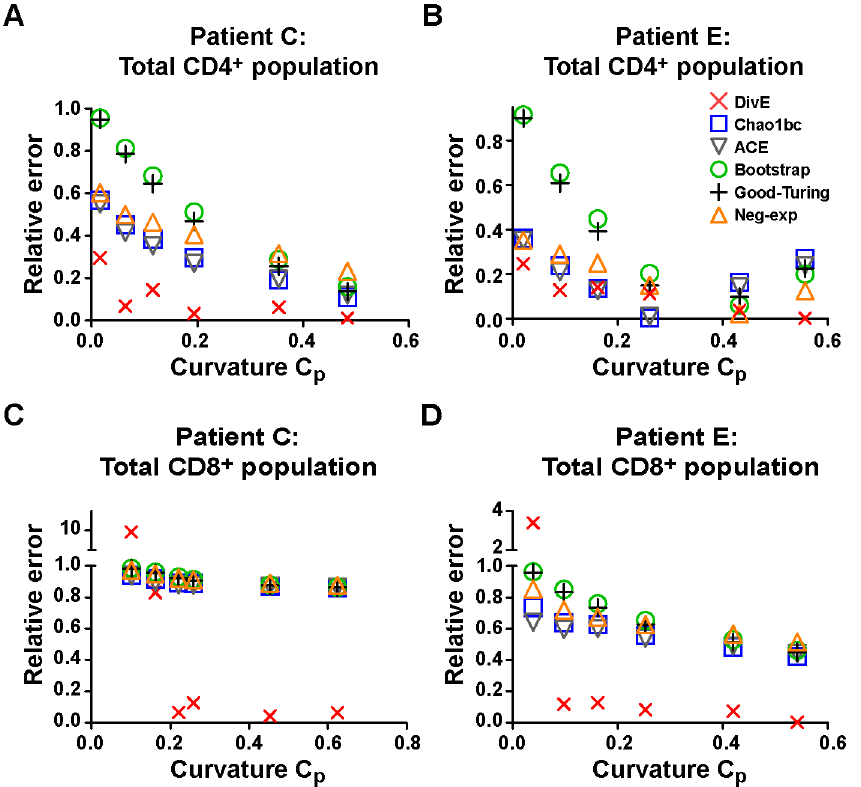
Figure 6. Test of species richness estimators at different values of curvature parameter ( C p ) using TCR data. The curvature parameter C p is plotted against the relative error (| S obs - Sˆ obs | / S obs ) of each estimator. Four patient data sets are shown: A total CD4 + from patient C; B total CD4 + from patient E; C total CD8 + from patient C; D total CD8 + from patient E. Each point represents an estimate from a subsample of data. Note the plots have different y-axis scales and the y-axes in C and D are segmented. Broadly, the accuracy of all estimators improves as C p increases, and this increase is more pronounced for DivE . From C p . 0.1, DivE generally outperforms the existing estimators, but is prone to error at very low values of C p ., when the rarefaction curve implies a near-constant rate of species accumulation.